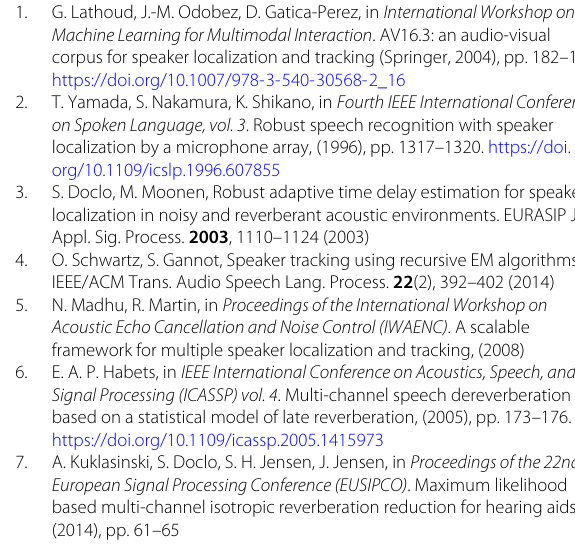
high localization and calibration accuracy even in these challenging